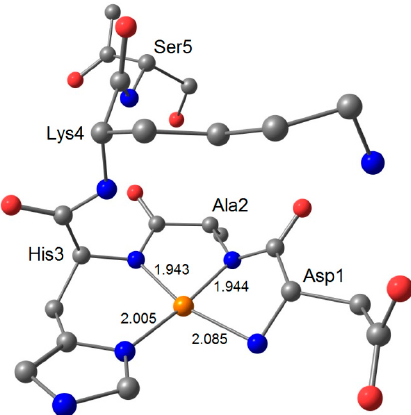
Figure 3. Optimized structure at the level of theory B3LYP-D3 of the adduct formed by Cu(II) with the pentapeptide AspAlaHisLysSer–NHCH 3 (region 1–5 of HSA). The Cu–donor distances (in Å) are also indicated. Hydrogen atoms are omitted for clarity. Table 4. Experimental spin Hamiltonian parameters for the interaction of Cu(II) with HSA and fragments 106–126 and 180–193 of prion protein, and comparison with the values calculated by DFT methods.